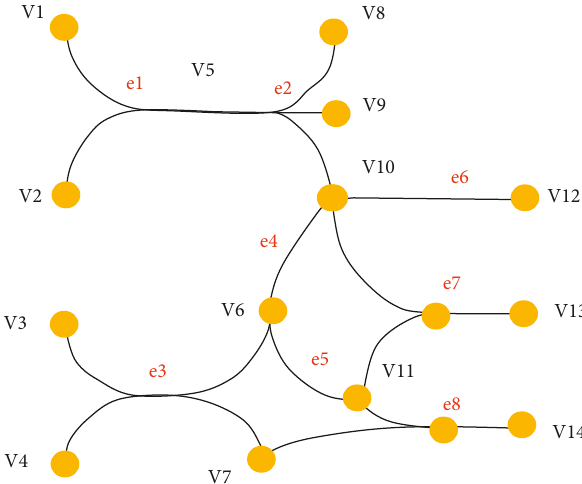
Figure 3: Representation of a directed hypergraph H .